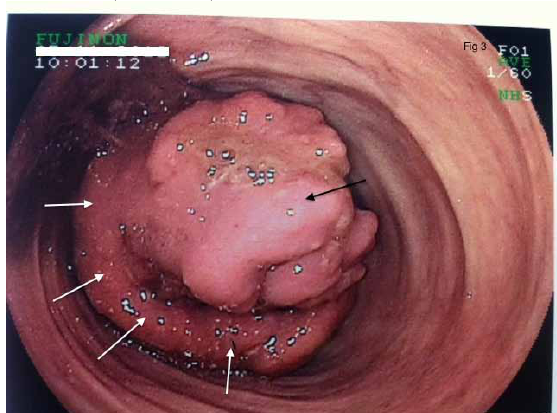
Figure 2. Colonoscopic photograph showing a large polypoidal lesion (black arrow) leading the intussuscepting segment (white arrows).